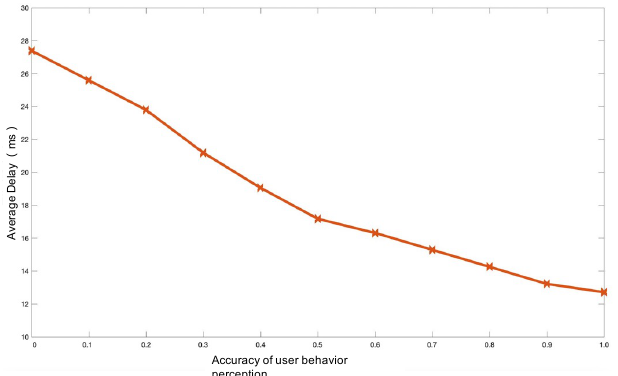
Figure 8. Comparison of user behavior